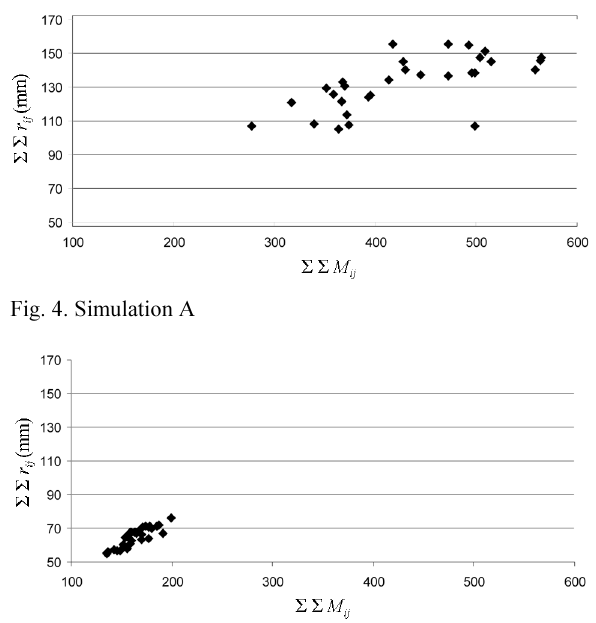
Fig. 5. Simulation B